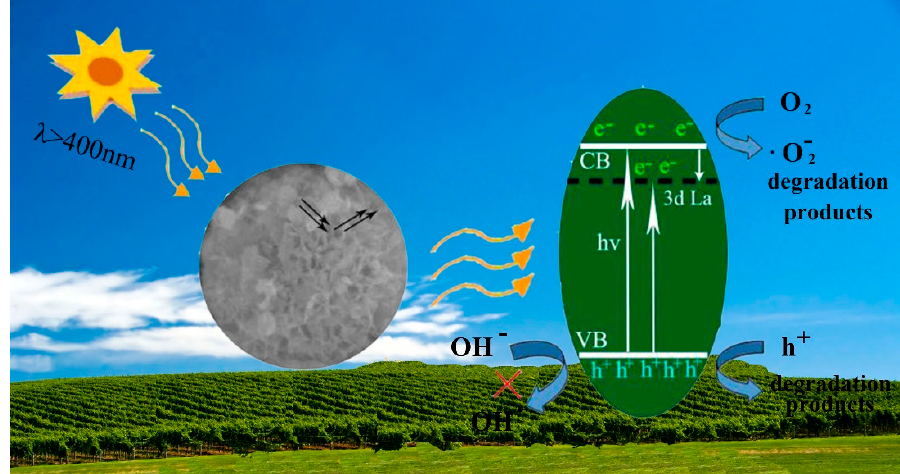
Figure 11. Schematic diagram of proposed reaction mechanism over La-doped ZIS system under visible-light irradiation.